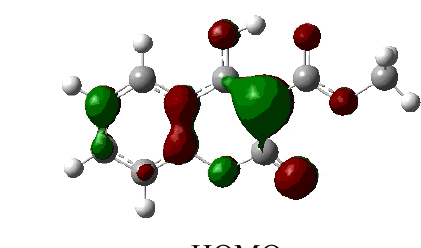
Figure 7. HOMO and LUMO orbitals of 3-methoxycarbonyl-4-hydroxy coumarin.